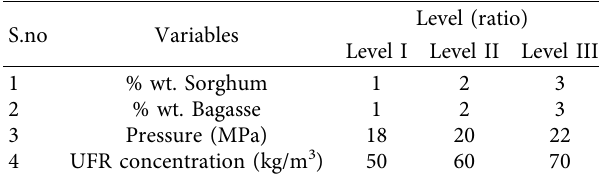
Figure 1: Raw material for reinforcement: (a) sorghum stalk and (b) sugarcane bagasse. Table 1: Control variables and their